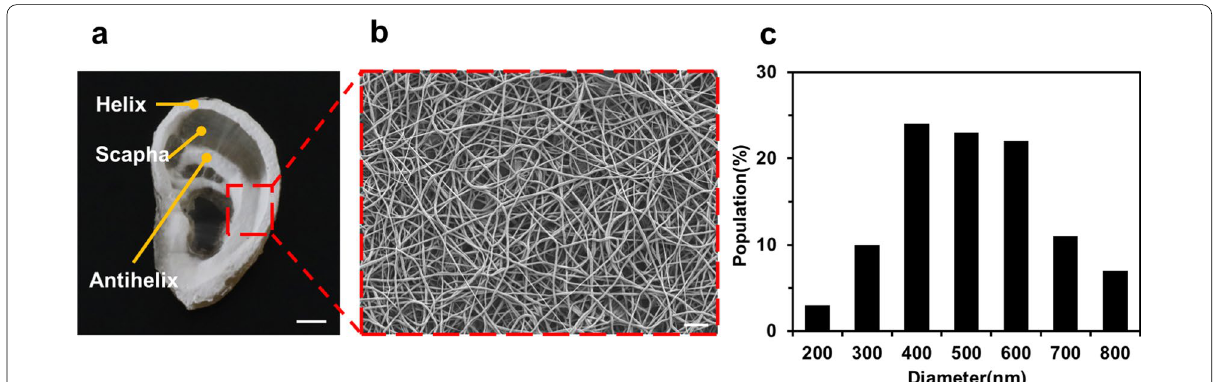
Fig. 3 a An electrospun nanofiber mat on the 3D ear cartilage-shaped hydrogel collector. b A magnified image of the electrospun nanofiber mat on the 3D ear cartilage-shaped hydrogel collector dashed in ( a ). c The population of the electrospun nanofibers on the 3D ear cartilage-shaped hydrogel collector. The scale bars are 1 cm ( a ) and 1 µm ( b